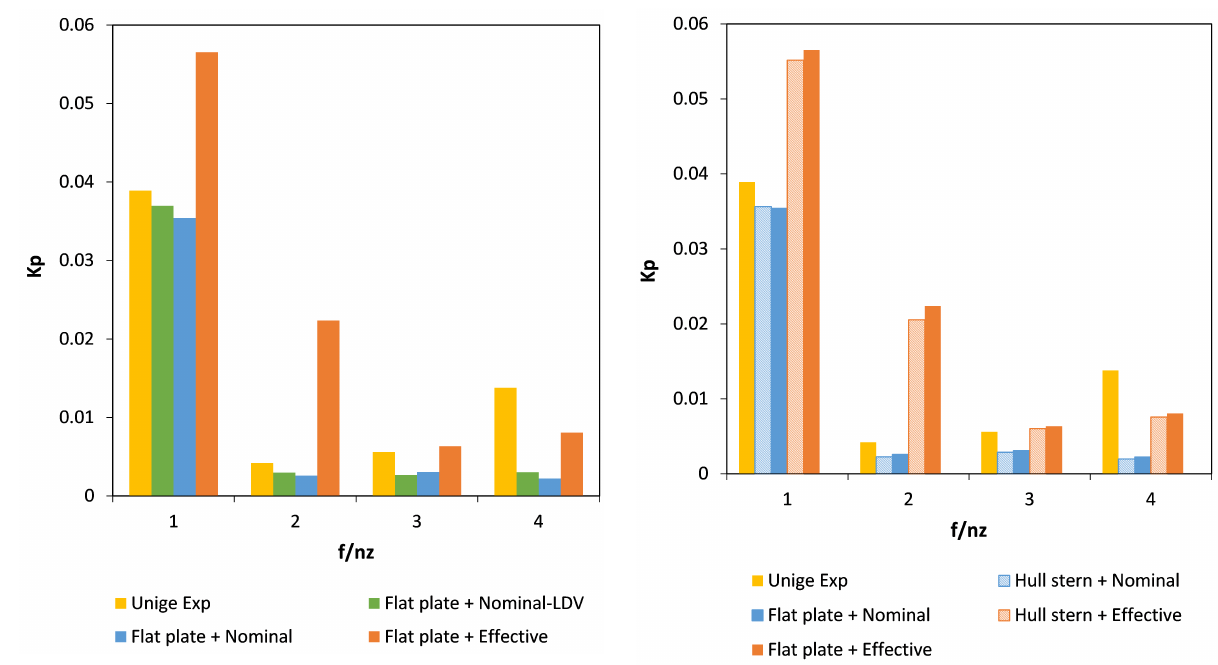
Figure 12: Pressure pulses in correspondence to the cavitation tun- nel measuring point. Comparison between numerical results (differ- ent inflow wakes) and experimental measurements.